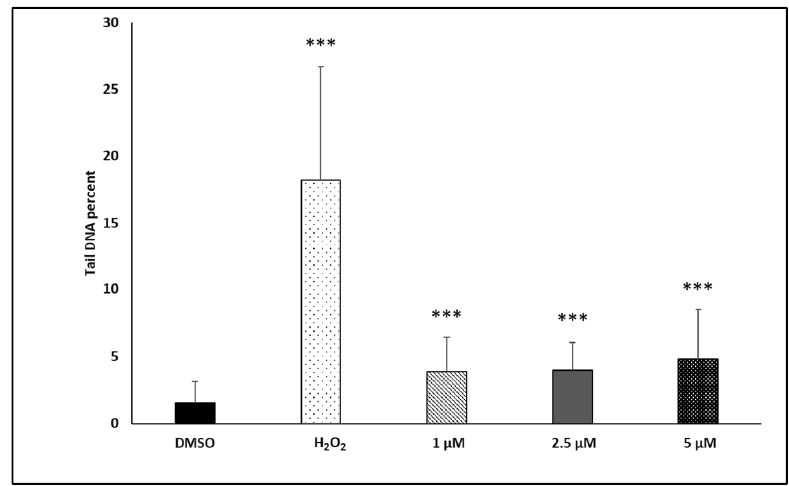
Figure 9. Comet assay of CCRF-CEM cells incubated with DMSO (negative control), H 2 O 2 (positive control), or artemisinin dimer isoniazide. Comets indicative of DNA damage were observed upon treatment with H 2 O 2 and increasing concentrations of artemisinin dimer isoniazide but not in DMSO-treated cells. Statistical significance in comparison to control (DMSO) is designated at a level of *** p ≤ 0.001.